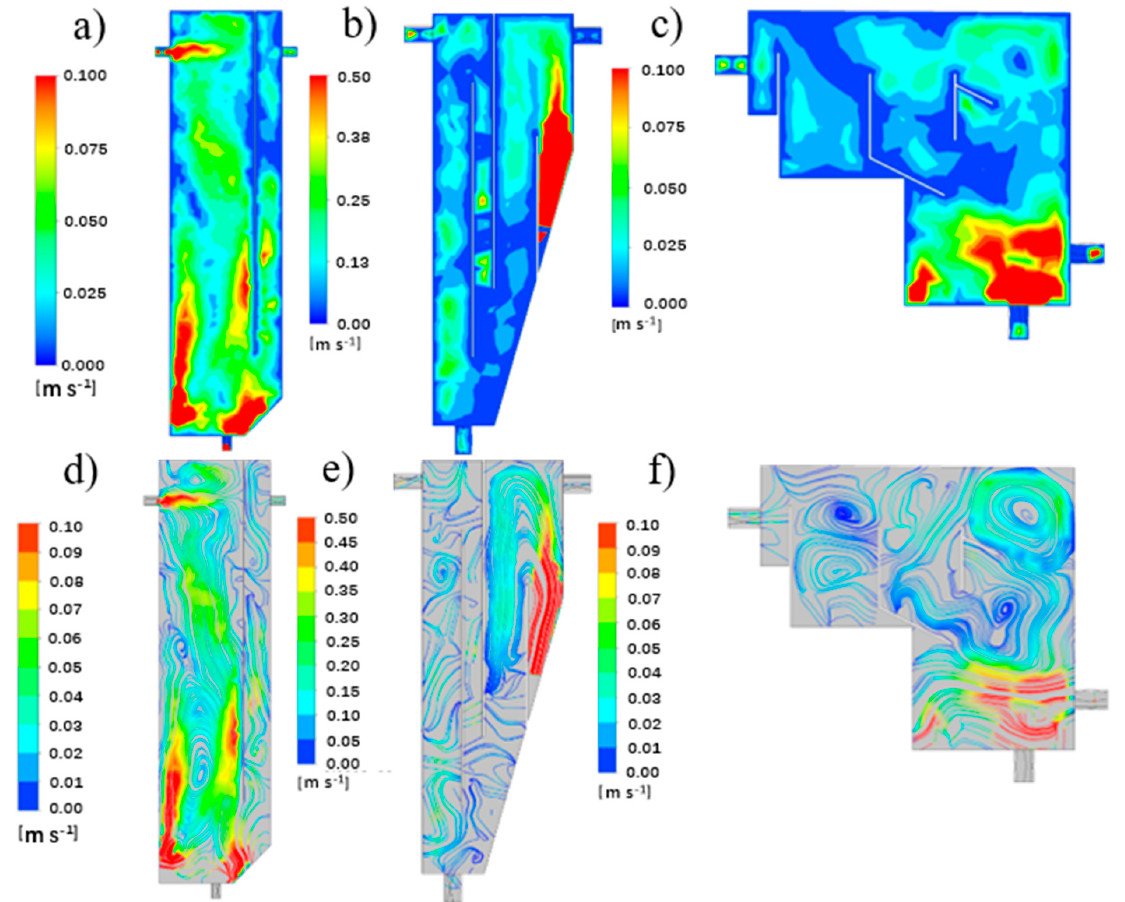
Figure 3. The water velocity contour and liquid velocity streamline of R1 ( a , d ), R2 ( b , e ) and R3 ( c , f ).